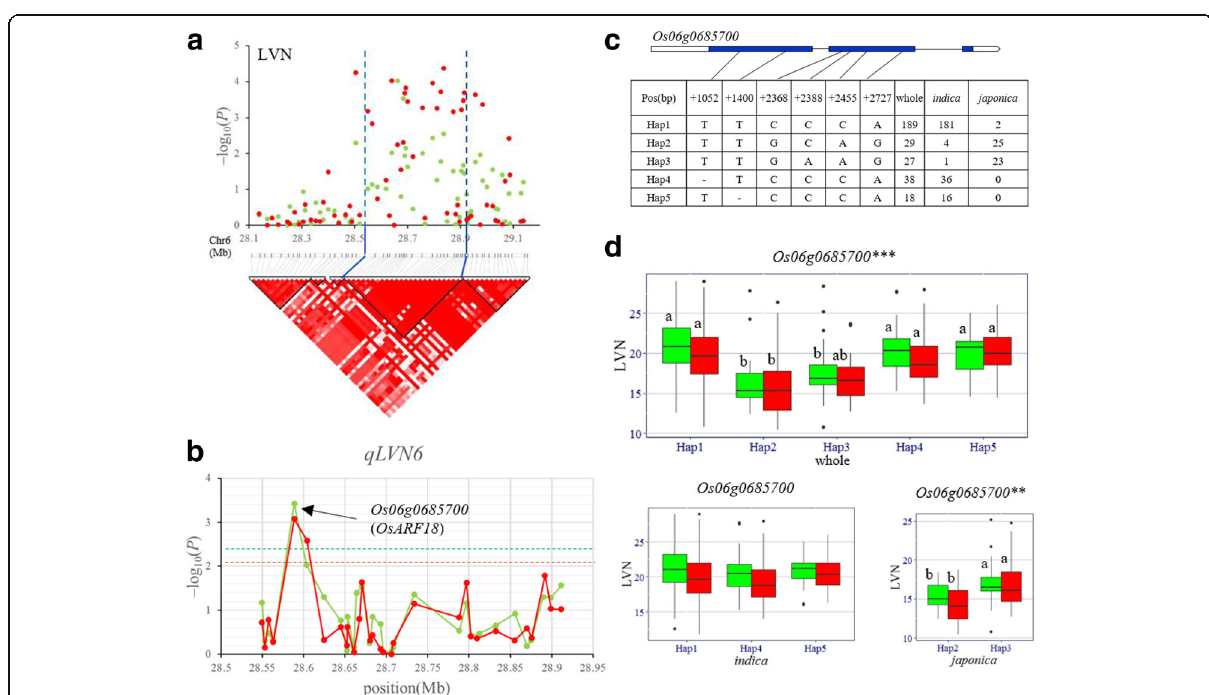
Fig. 3 Gene-based association analysis and haplotype analysis of targeted genes related to qLVN6 . a Local Manhattan plot (top) and LD block (bottom) surrounding the peak on chromosome 6. Dashed lines indicate the candidate region for the peak. b Gene-based association analysis of targeted genes related to qLVN6 . Each point is a gene indicated by one SNP having largest – log10 ( P ) value. Dash line show the threshold to determine significant SNP. c Exon-intron structure of Os06g0685700 and DNA polymorphism in that gene. d Boxplots for LVN based on the haplotypes (Hap) for Os06g0685700 in the whole, indica and japonica populations. The ** and *** suggest significance of ANOVA at P <0.01 and P <0.001, respectively. The letter on histogram (a, and b) indicate multiple comparisons result at the significant level 0.05. Green and red colors indicate in 2015 and 2016,